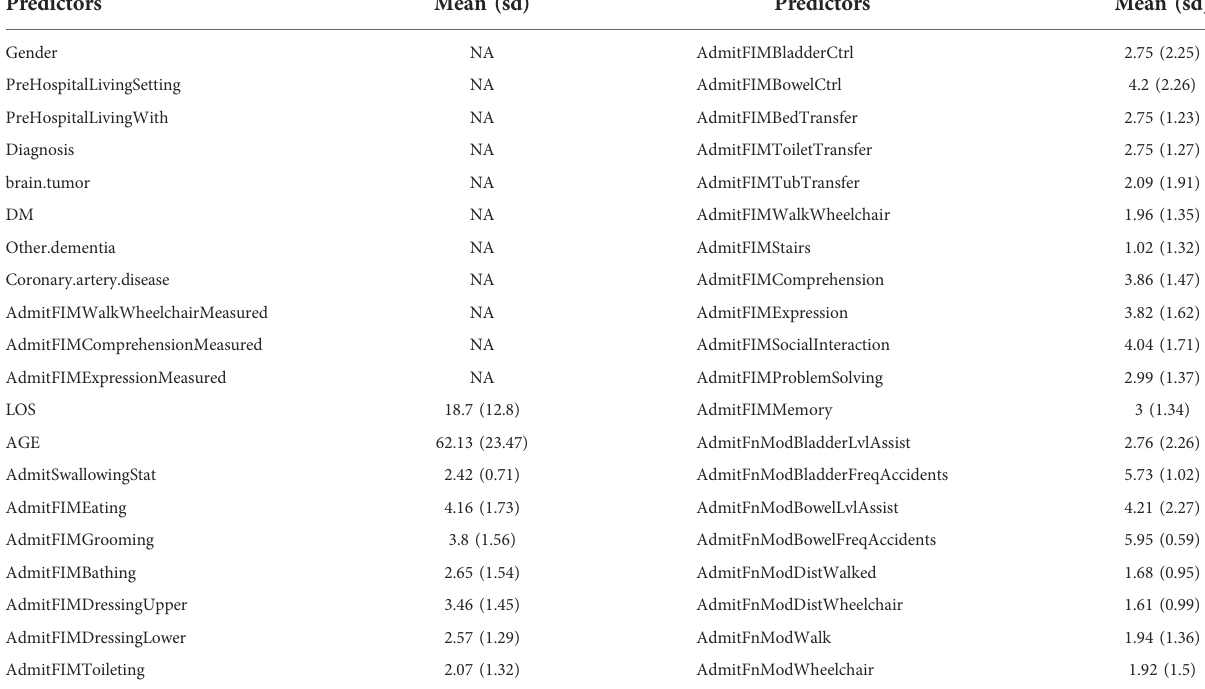
TABLE 1 Mean and standard deviation of input features used in all predictive